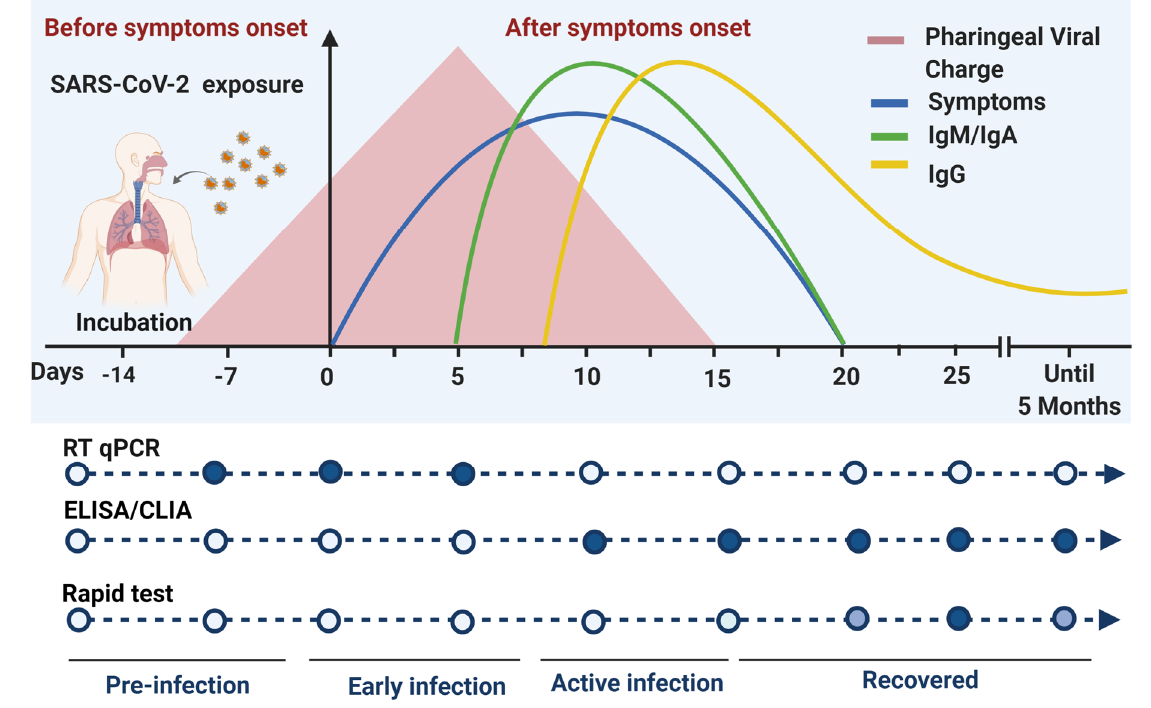
Figure 3. Timeline for the accurate detection of COVID-19 with authorized tests in Mexico. Due to its nature, detection of Figure 3 SARS-CoV-2 and diagnosis of COVID-19 implies the appropriate combination of detection methods and medical supervision. The most important point for making decisions in a probable case validation is the symptom establishment day (day 0). Depending on the time between the symptom onset and when the patient arrives at the hospital, applicability of the detection methods can change. Viral RNA can be detected by RT-qPCR on pharyngeal samples in the first days after symptoms establishment. Antibodies can be produced as soon as 5 days after symptoms establishment but most of the infected patients take until a month to produce detectable levels of antibodies. CLIA: chemiluminescent